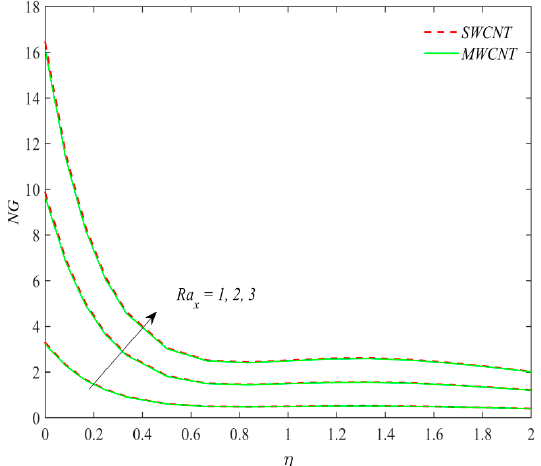
Figure 23. The variation of the entropy optimization NG for the case of SWCNT and MWCNT versus